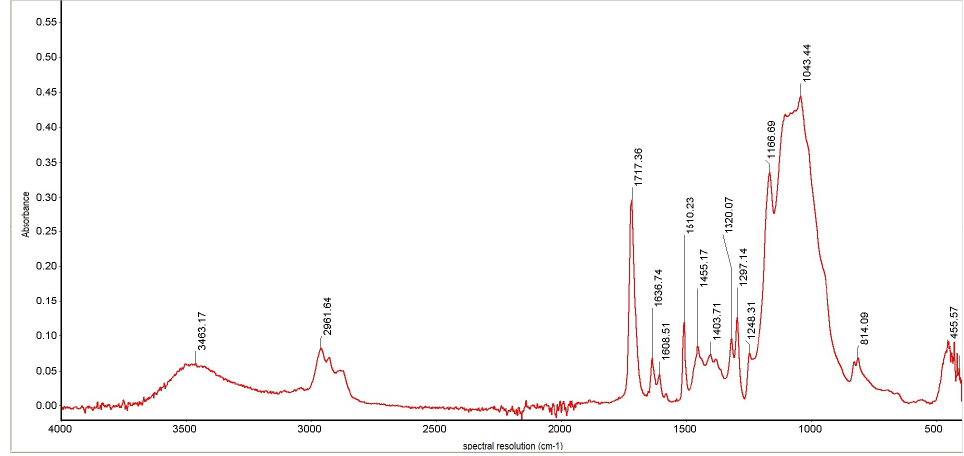
Figure 11. IR spectrum for the sample 1.